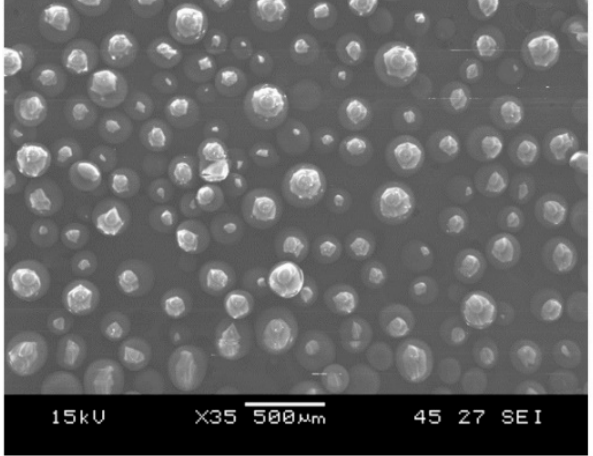
Figure 1. SEM image of PMMA particles.